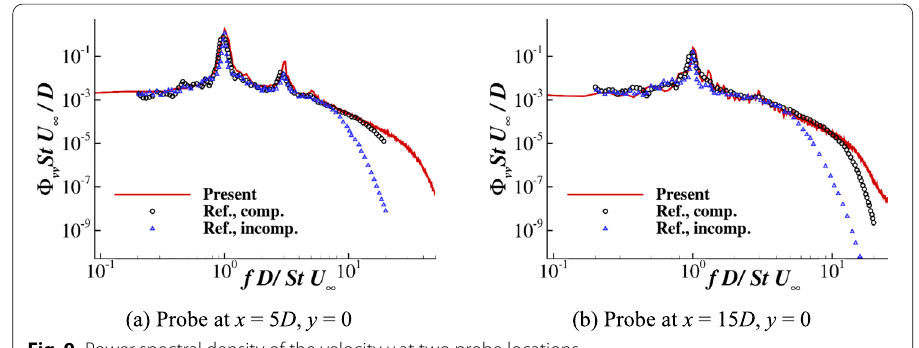
Fig. 9 Power spectral density of the velocity v at two probe locations